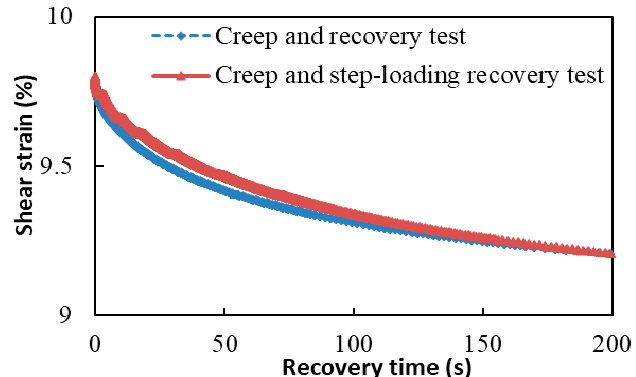
Figure 4. Measured shear strain of the CSR test and creep recovery test